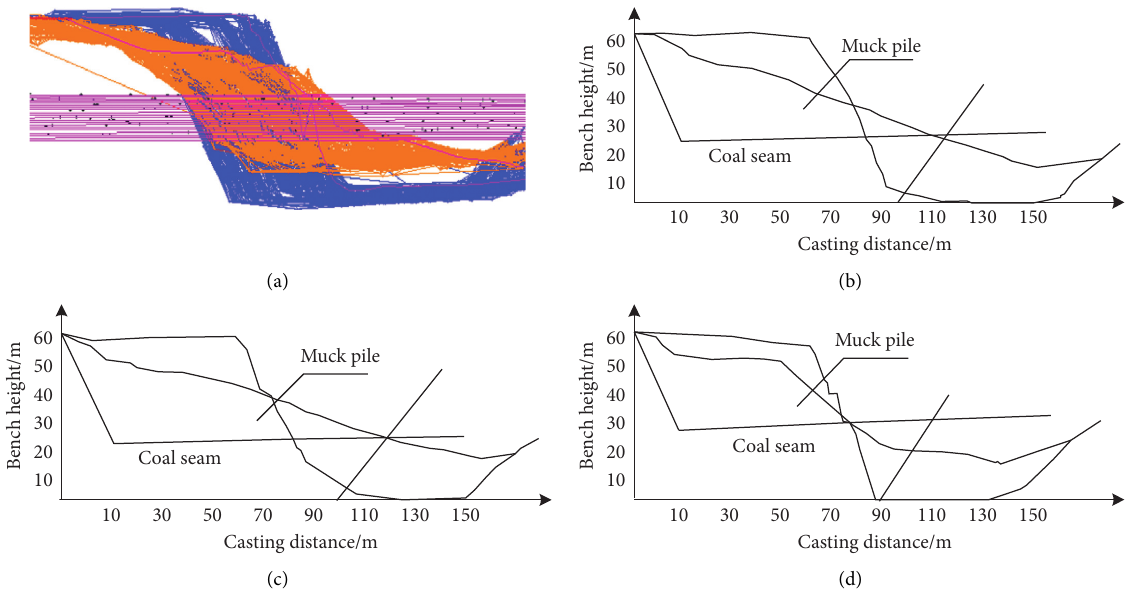
Figure 4: Schematic diagram of muck pile form of blast casting. (a) Scanned vector of muck pile shape. (b) N7-7 th section view. (c) N7-13 th section view. (d) N7-21 th section view.